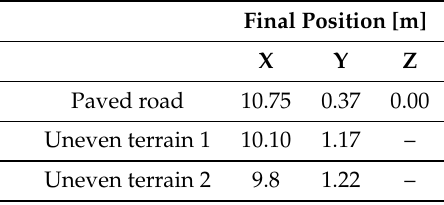
Table 14. Results for the outdoor scenario 2 test 1: Walking